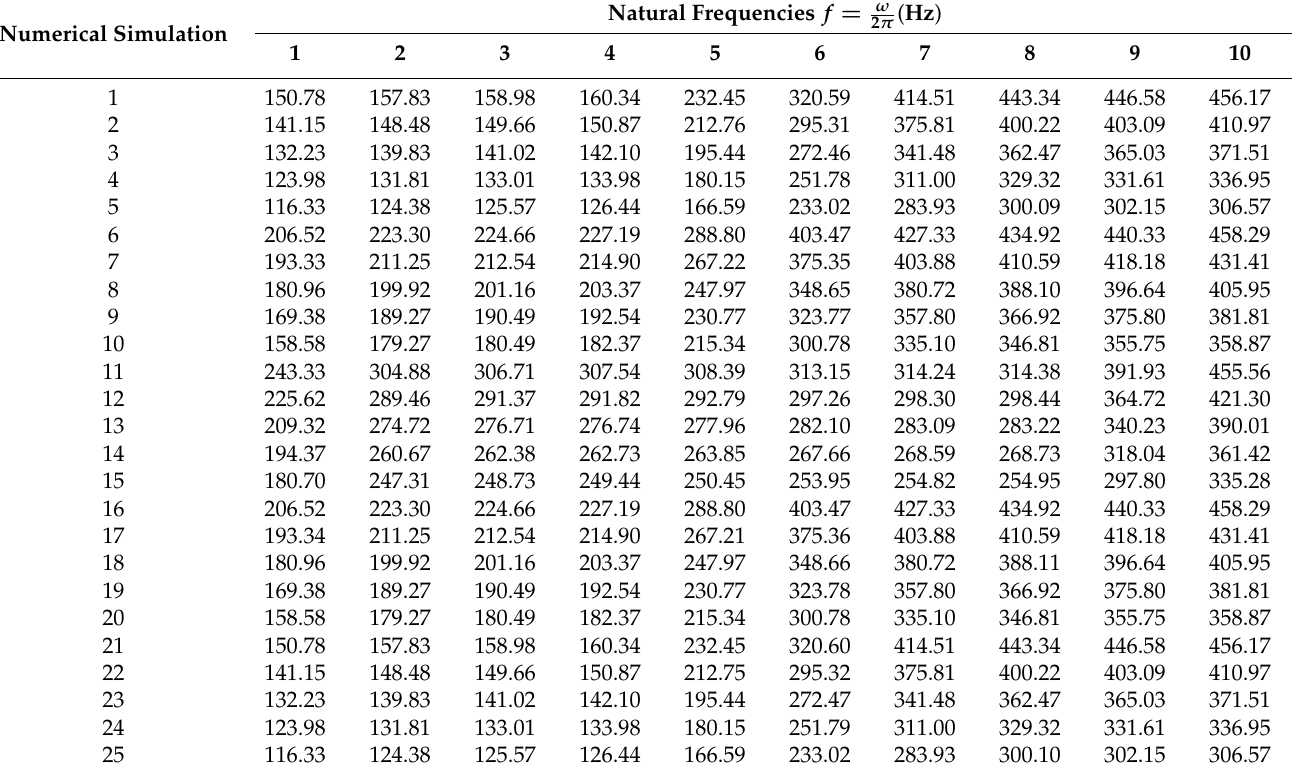
Table 5. Taguchi-based natural frequencies of the morphed